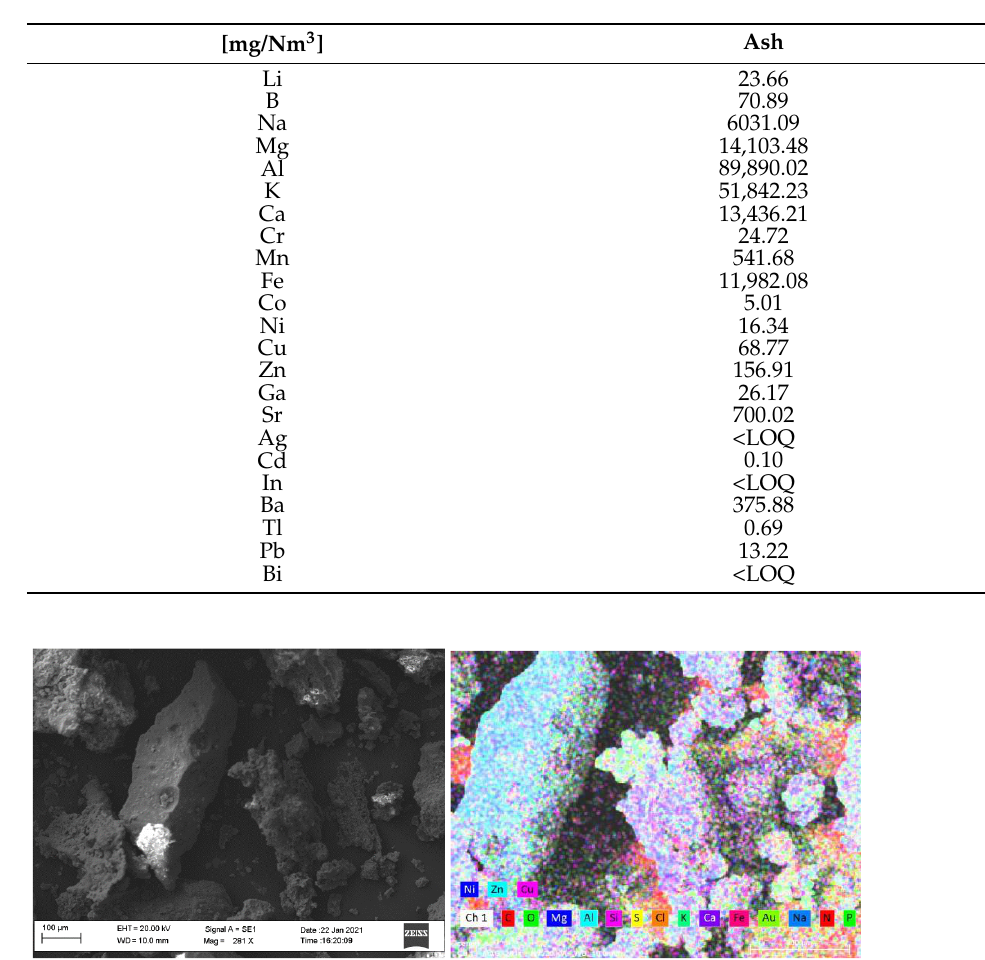
Table 9. Metals content of ash after combustion.